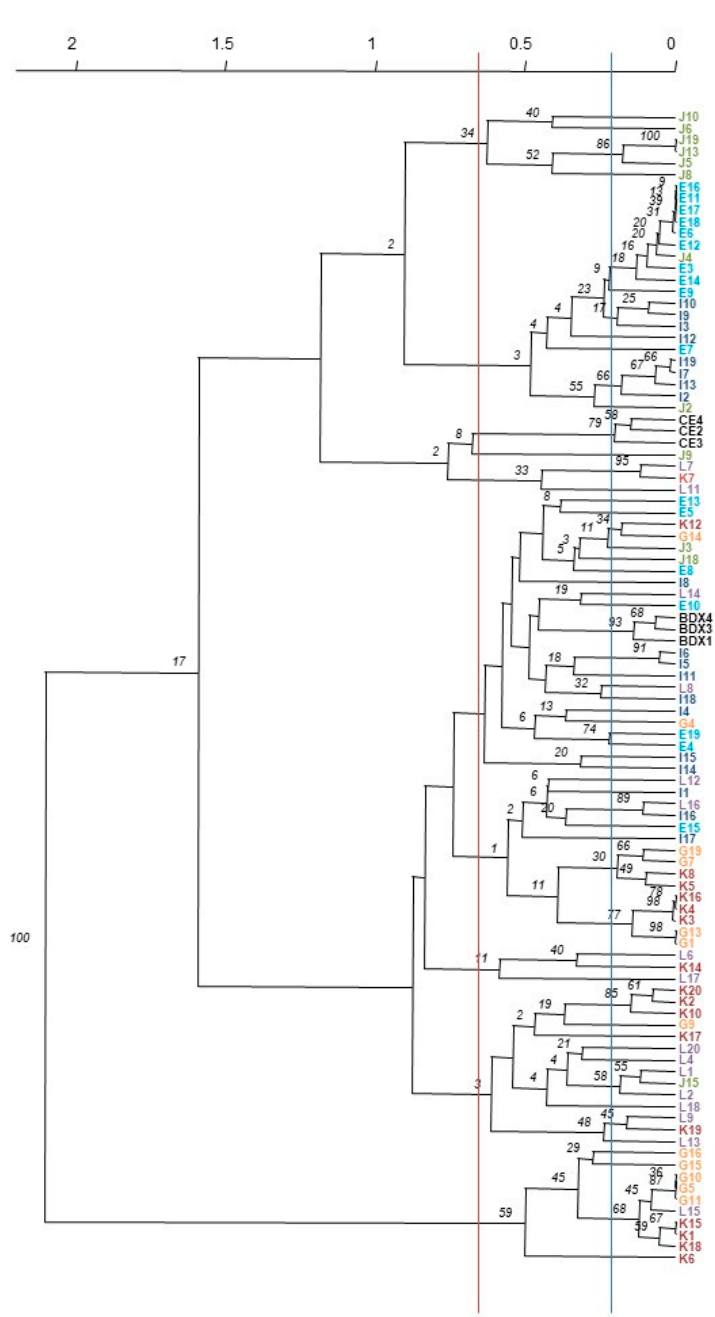
Figure 1. Dendrogram presenting the genetic distance between the S. cerevisiae isolates from Arbutus unedo fermentations (codes in Table 6) and ADY isolates (codes CE and BDX) based on microsatellite profiles. The scale at the top represents genetic distance. The blue line and the red line across the dendrogram represent the strain and the closest genetic levels,